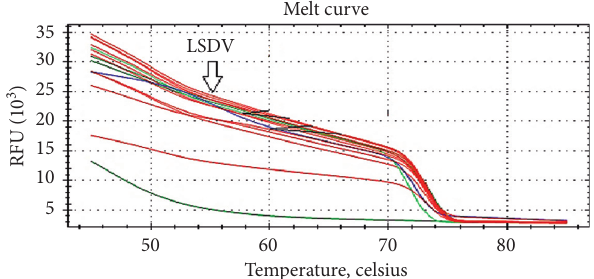
Figure 6: Melting curve analysis of field isolates of LSDV.